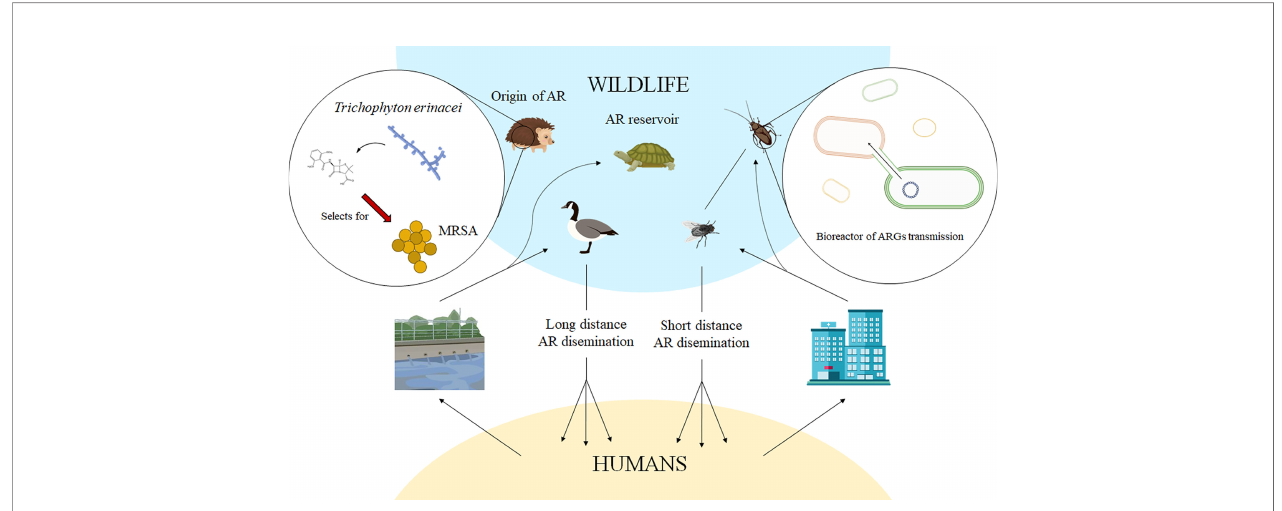
FIGURE 1 | Contribution of wildlife to antibiotic resistance. When talking of the problem of antibiotic resistance, it is important to highlight that it refers to antibiotic resistant bacteria or antibiotic resistance genes that are a problem for human health, not just to the plethora of intrinsically resistant bacteria or resistance genes present in any ecosystem but not involved in human ’ s infections. Current evidence supports that human antibiotic resistant pathogens and the resistance genes they harbour are found in wild animals, which are hence a reservoir of antibiotic resistance. In the case of migratory animals, as gulls, they might contribute to long- distance dissemination of antibiotic resistance, while non-migrating animals, as fl ies or cockroaches, may have a role in said dissemination at shorter distances. The fi nding that antibiotic resistance genes can disseminate across bacteria present in the microbiota of insects, as cockroaches, which have a tight contact with humans, supports that these organisms might act as bioreactors mediating the spread of antibiotic resistance among bacterial pathogens. Besides their involvement in the dissemination of antibiotic resistance, recent fi ndings support that wild animals might have a role in the origin of antibiotic resistance. This is the situation of methicillin resistant S. aureus (MRSA) that might have been selected in hedgehogs, long before the therapeutic use of antibiotics, as a response to the presence of b -lactam-producing microorganisms in the microbiome of this wild mammal. AR, antibiotic